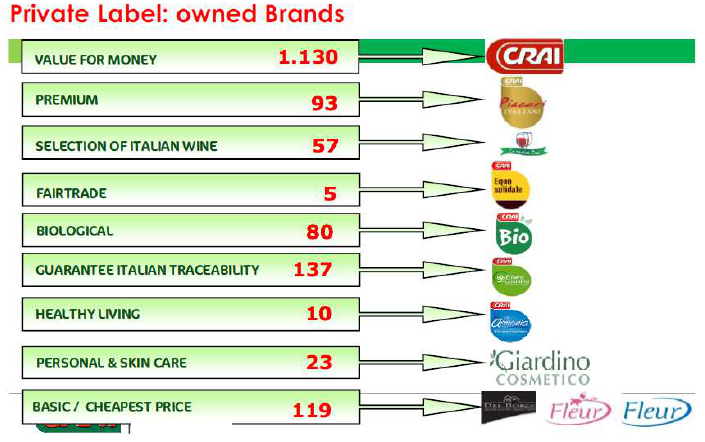
Figure 1 : CRAI Private Label Portfolio